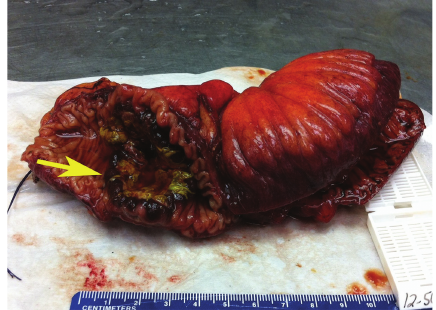
Figure 2: Surgical specimen of the resected small